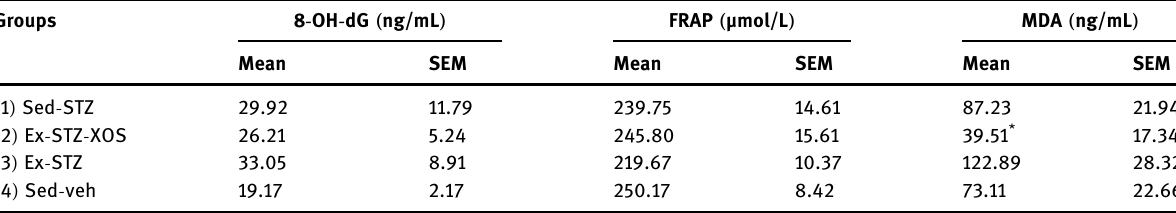
*Signi fi cant di ff erences with p = 0.034 in comparison to Ex - STZ.